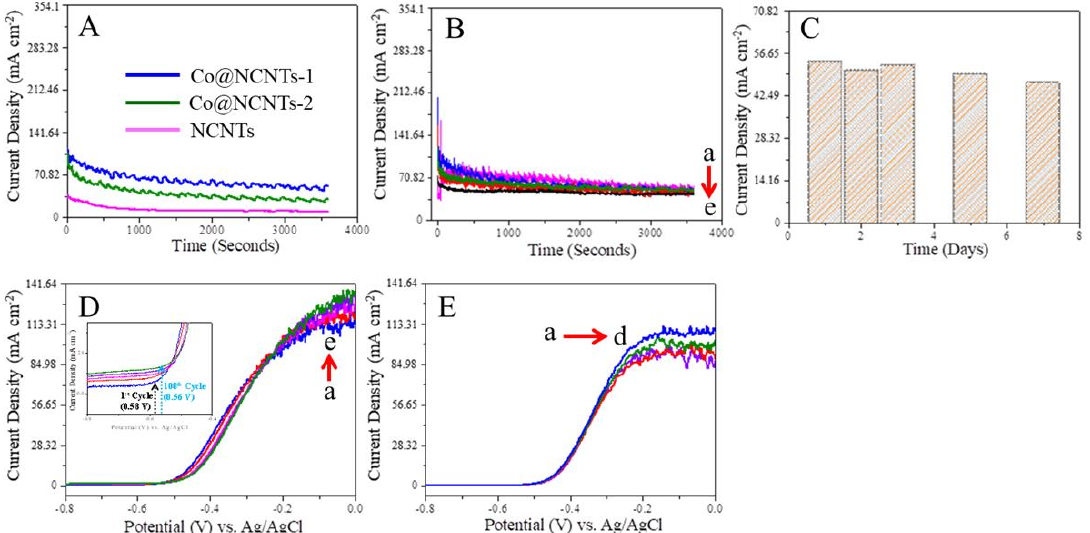
Figure 6. ( A ) Chronoamperomeric i-t curves obtained for NCNTs (pink line), Co@NCNTs − 1 (blue line), and Co@NCNTs − 2 (green line) modified GCEs in 1.0 M NaOH solution containing 0.1 M hydrazine at an applied potential of 0 V vs. Ag/AgCl under constant stirring experimental solution. ( B ) Chronoamperomeric i–t curves obtained for Co@NCNTs − 1 modified GCEs at an applied potential of 0 V vs. Ag/AgCl. The i–t curves recorded after 1 day (a), 2nd day (b), 3rd day (c), 5th day (d), and 7th day (f), and corresponding bar plot showing their exact current responses ( C ). ( D ) LSV polarization curves obtained for different cycles using Co@NCNTs 1 electrode in 1.0 M NaOH solution containing 0.1 M hydrazine at a scan rate of 10 mV s − 1 (a) 1st cycle, (b) 25th cycle, (c) 50th cycle, (d) 75th cycle, and (e) 100th cycle. ( E ) LSV polarization curves obtained for four ‐ different Co@NCNTs 1 electrodes in 1.0 M NaOH solution containing 0.1 M hydrazine at a scan rate of 10 mV s − 1 ; (blue line) 1st electrode, (green line) 2nd electrode, (red line) 3rd electrode, and (vi ‐ olet line) 4th electrode.